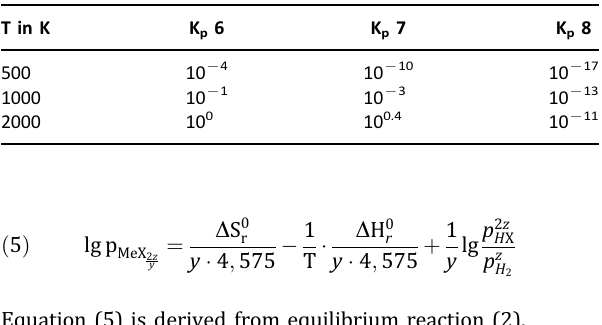
Table 1. Equilibrium constants K p at different temperatures (T) for equilibrium reactions involved in the CFT model of mineral formation (Schrön, 1989b, 2013). 6 = kamacite/taenite, 7 = troilite, and 8 = schreibersite.